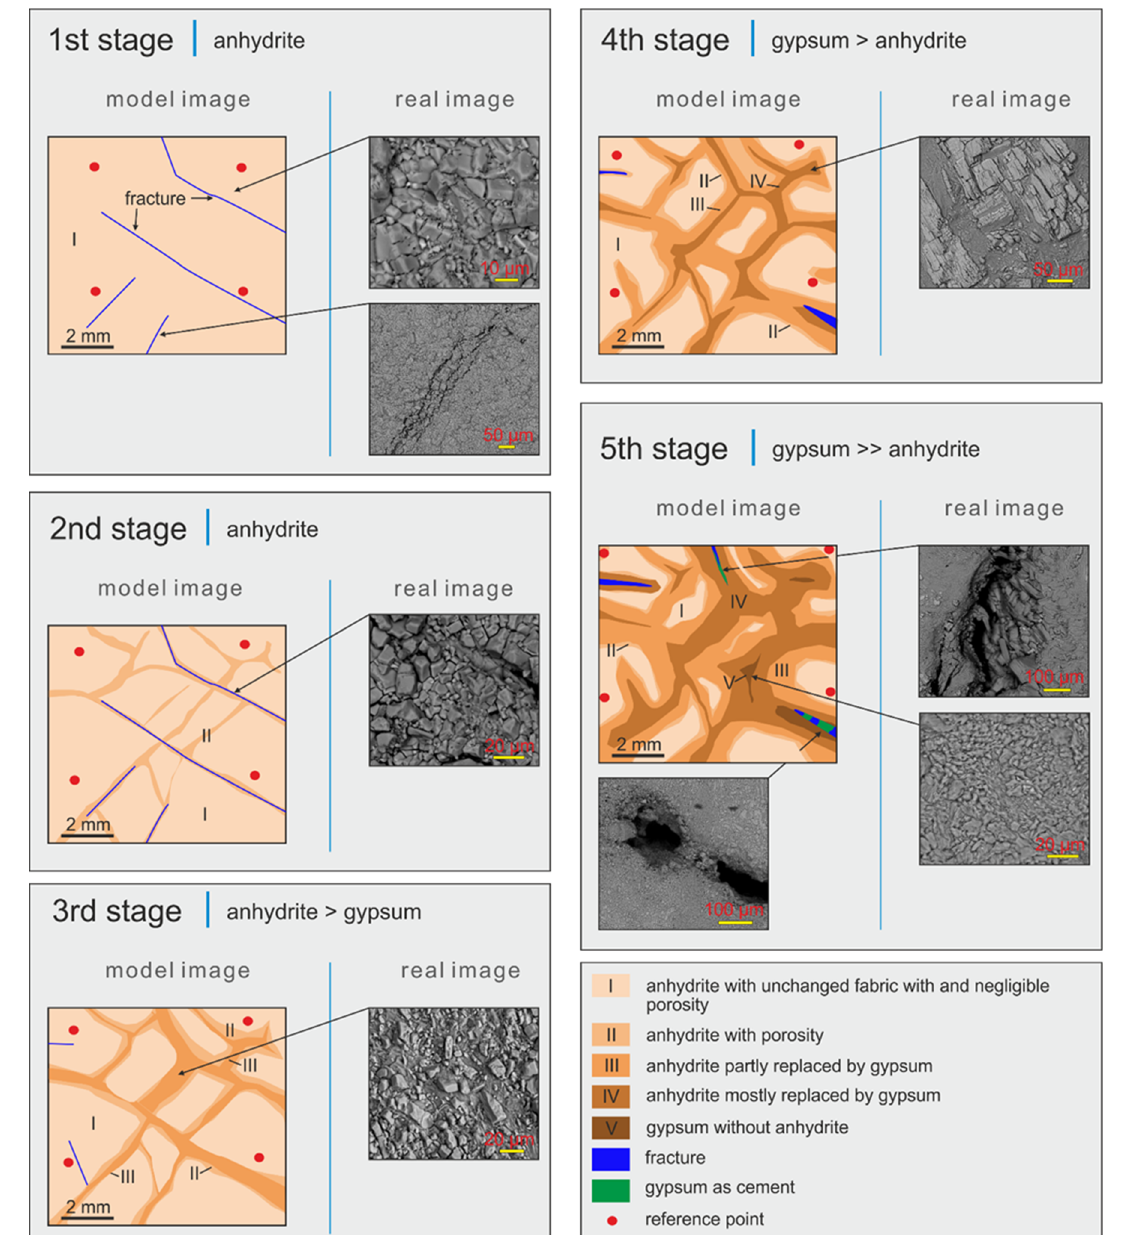
Figure 9. Model of anhydrite gypsification in the weathering zone consisting of five stages with presentation of volume increase by reference points, for the sake of simplicity only selected larger fractures are shown, real images are BSE images: first stage–fracturing of the massive anhydrite; second stage–dissolution of the anhydrite along fractures; third–fifth stage–expansive anhydrite hydration: dissolution of anhydrite and replacive-displacive crystallization of gypsum, as well as crystallization of gypsum cements (stage 5th). Further explanations in the